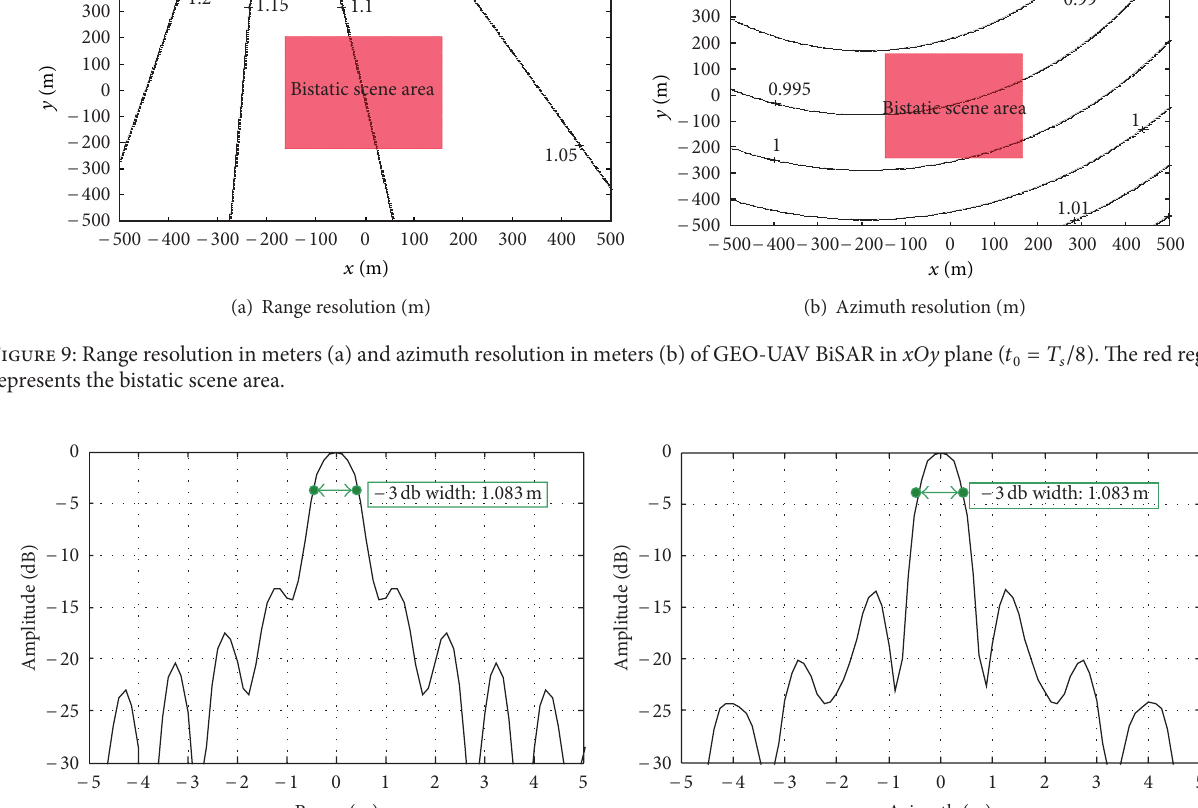
− Ψ) obtains the maximum 15 ∘ when 𝑡 max (Ψ var